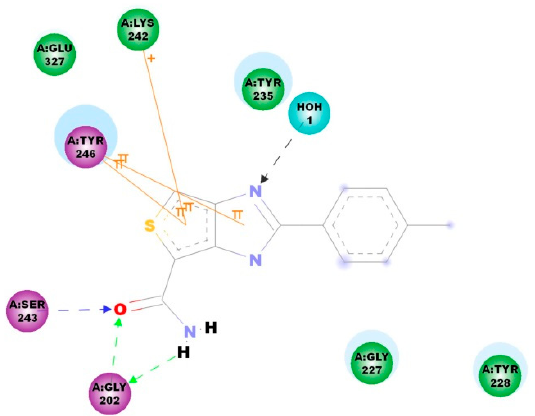
Figure 4. 2D diagram of compound 16l docking in the catalytic domain of human PARP-1 (PDB code: 2RD6).